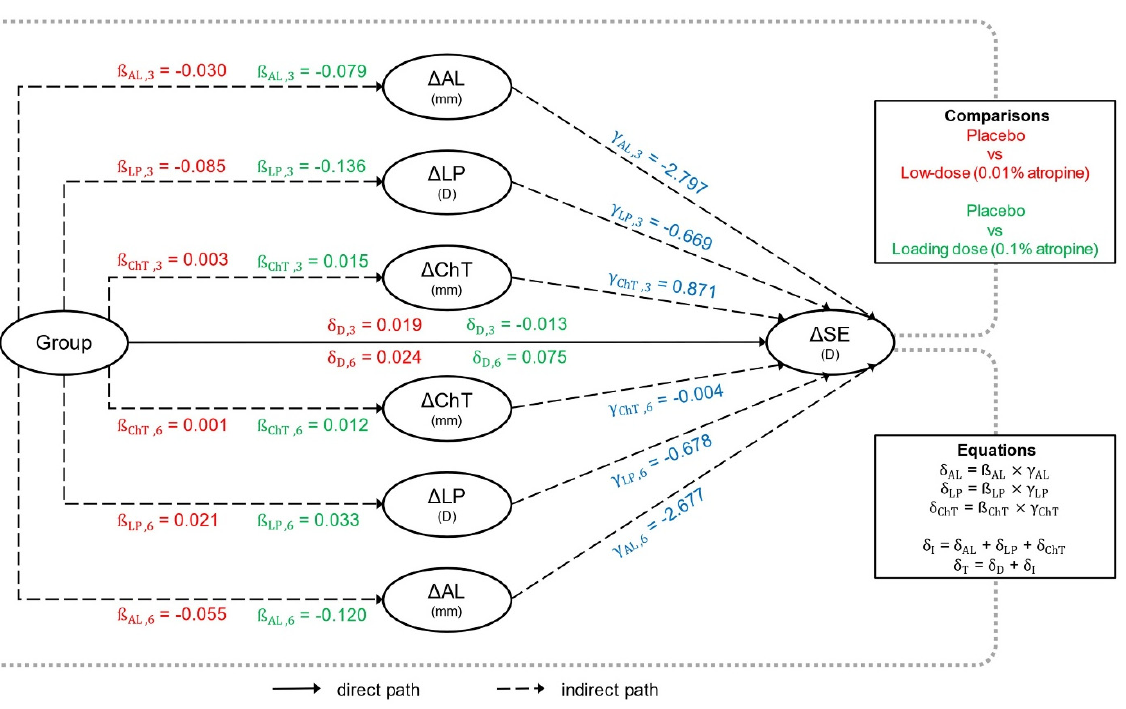
Figure 2. The figure illustrates the results from the mediation analyses. The upper and lower rectangles (marked by dotted lines) report the mediations at 3 and 6 months, respectively. Group-dependent associations ( β ) are depicted in red (placebo versus low dose) and green (placebo versus loading dose). Group-independent associations ( γ ) between intermediate outcomes (AL, LP, ChT) and the dependent outcome (SE) are depicted in blue. Group-dependent direct mediations ( δ D ) are drawn in solid lines, whereas indirect mediations are drawn in dotted lines. The equations for determining the mediated effect through an independent variable and the indirect mediation are shown in the equation box. Effect size estimates, differences, and significance levels are reported in Table 3. Abbreviations: Δ = change in; AL = axial length; ChT = choroidal thickness; D = diopters; LP = lens power; SE = spherical equivalent. Table 3. Mediation analyses.